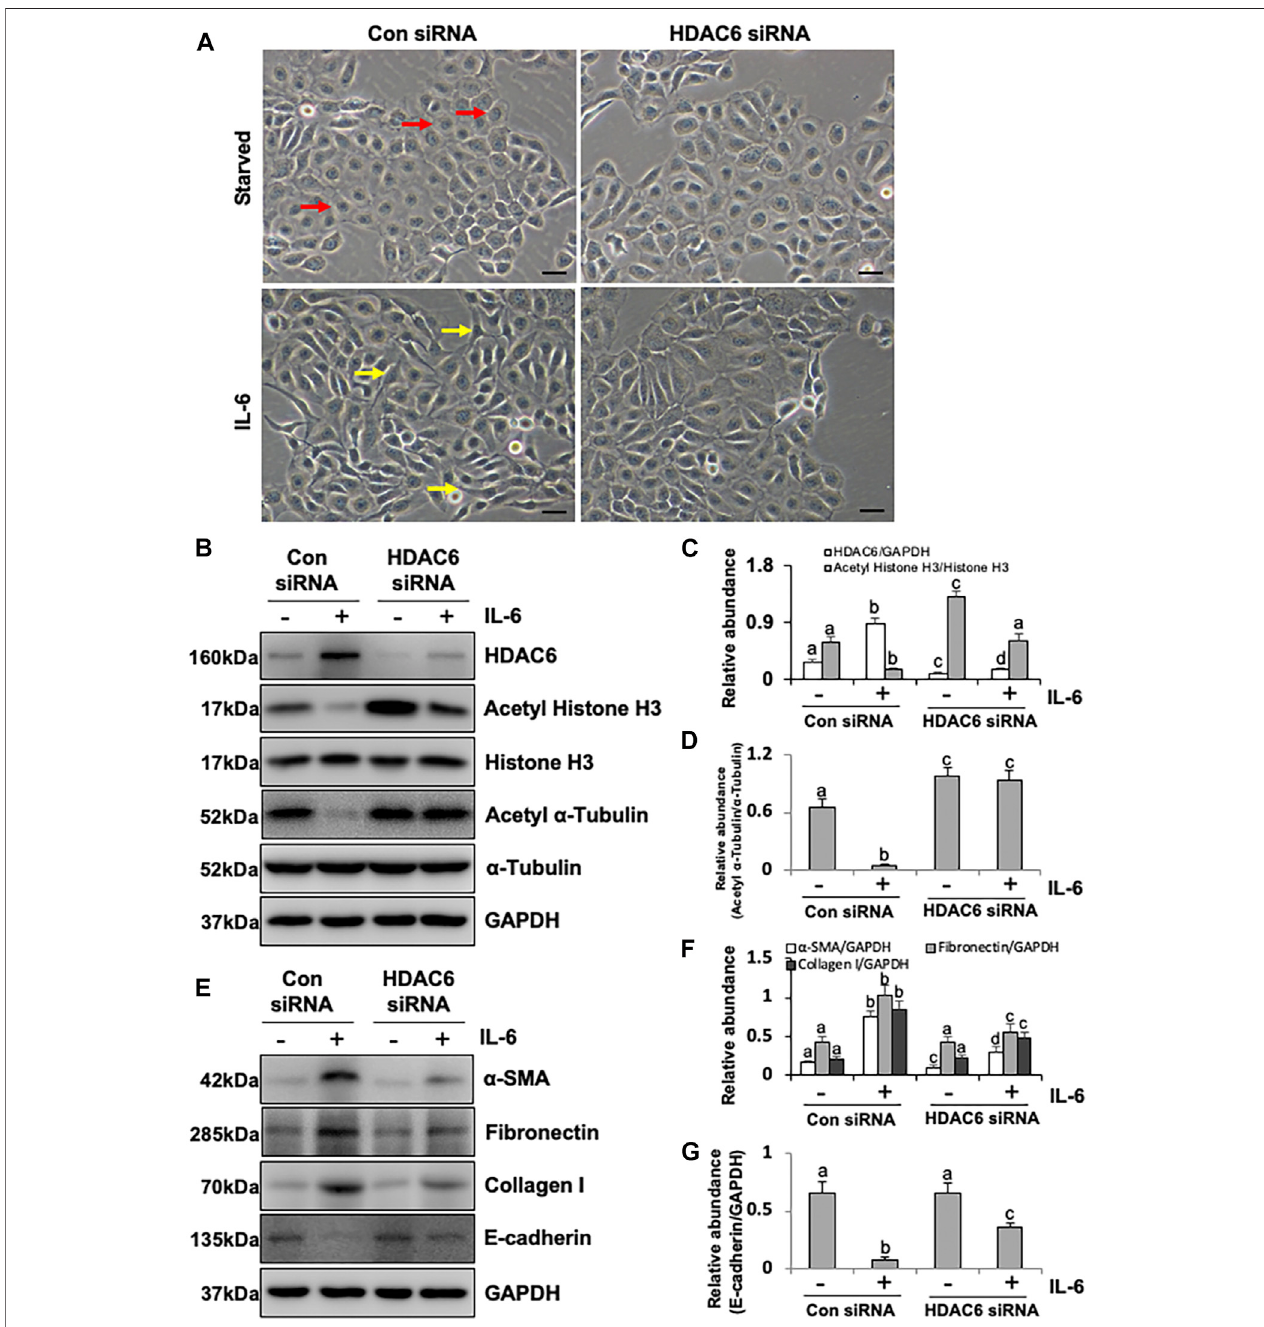
FIGURE 3 | siRNA-medicated silencing of HDAC6 inhibits EMT of peritoneal mesothelial cells. (A) Cell morphology was observed using light microscopy. The red arrows indicated the cobblestone-shaped cells and the yellow arrows showed the spindle-shaped cells. (B) Cell lysates were subjected to immunoblot analysis with antibodies against HDAC6, Acetyl Histone H3, Histone H3, Acetyl α -Tubulin, α -Tubulin, and GAPDH. (C) Expression levels of HDAC6 and Acetyl Histone H3 were quanti fi ed by densitometry and normalized with GAPDH and total histone H3, respectively. (D) Expression level ofAcetyl α -Tubulin was quanti fi ed bydensitometry and normalized with total α -Tubulin. (E) Cell lysates were subjected to immunoblot analysis with speci fi c antibodies against α -SMA, Fibronectin, Collagen I, E-cadherin, and GAPDH. (F) Expression levels of α -SMA, Fibronectin, and Collagen I were quanti fi ed by densitometry and normalized with GAPDH. (G) Expression level of E-cadherin was quanti fi ed by densitometry and normalized with GAPDH. Data are represented as the mean ± SEM (n (cid:1) 3). Means with different superscript letters are signi fi cantly different from one another ( p < 0.05). All scale bars (cid:1) 100 μ m.